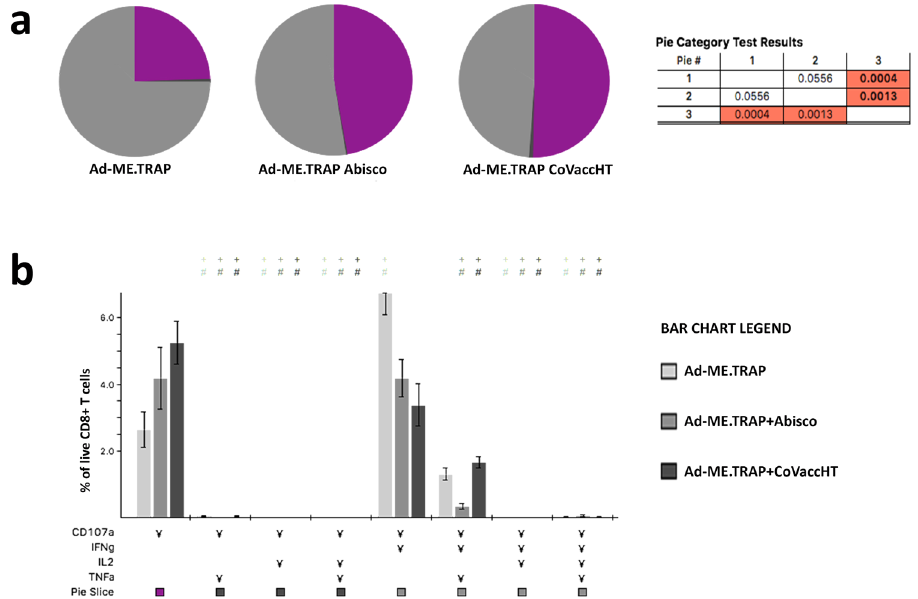
Figure 5. Functionality of CD8 + T cells: protective adjuvants induce higher levels of circulating CD8 + CD107a + IFN γ − TNF α − IL2 − T cells. BALB/c mice (n = 6) were immunized intramuscularly with Ad-ME.TRAP (5 × 10 9 vp/dose), alone or adjuvanted with Abisco ® -100 or CoVaccineHT and the cytokine profiles of CD8 + PBMCs two weeks post-immunization analysed using the SPICE software 18 . ( a ) Pie charts show the proportion of PBMC CD8 + T cells producing one or more of: CD107a, IFN γ , TNF α and IL2 upon in vitro stimulation with the Pb9 peptide. Vaccine received is indicated under each pie-chart. Purple coloured area represents cells that are positive only for CD107a and negative for IFN γ , TNF α and IL2. A statistically significant distribution was found between the group receiving Ad-ME.TRAP + CoVaccineHT TM and the other two groups (the p-values are shown in the Table next to the charts). ( b ) More detailed representation of the cytokine secreting profile among the vaccinated groups of mice. Each set of bars shows the proportion of CD8 + T cells secreting one or more cytokines (marked with ¥) in the three vaccinated